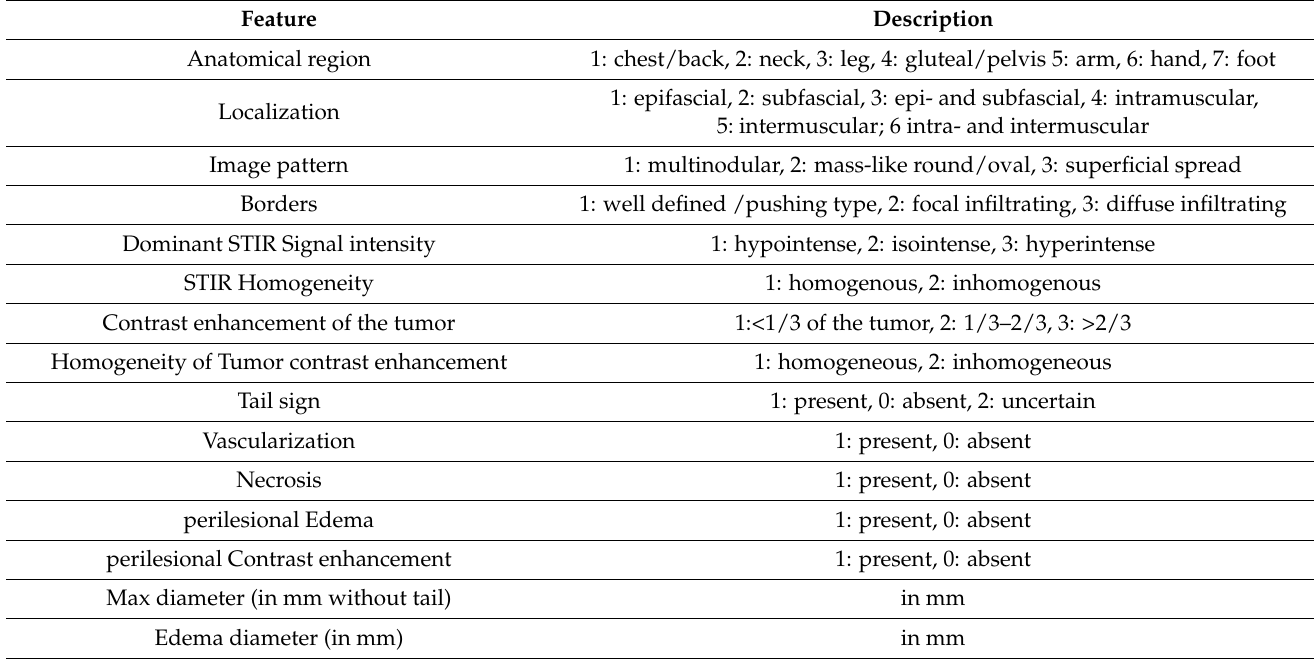
Table 1. Description of all semantic features extracted radiologist for the description of soft-tissue sarcomas. Feature Description Anatomical